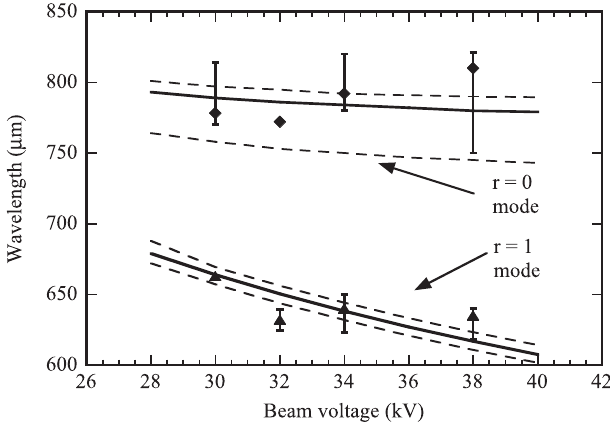
FIG. 8. Predicted (solid lines) and observed wavelengths over a range of voltages for r ¼ 0 (diamonds) and r ¼ 1 (triangles) modes. Dashed lines indicate variability in predictions due to variation in actual grating dimensions, while error bars on the data points represent the spread of observed